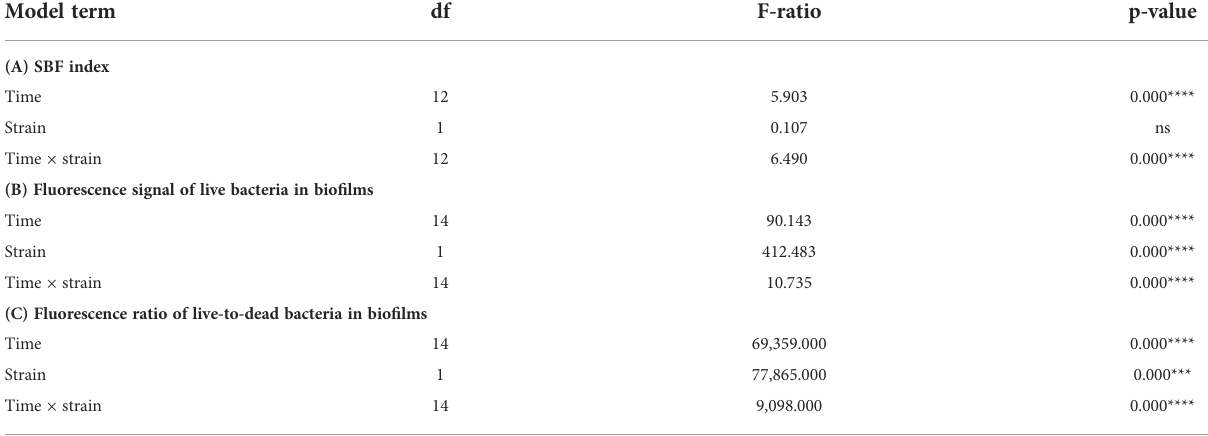
TABLE 1 Generalized linear model results for the effects of the “ time ” and “ strain ” factors (and their interaction) on different response variables. Model term